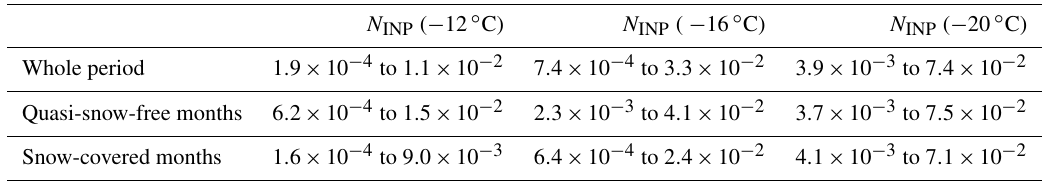
Table 1. Percentiles of N INP (10th to 90th) at − 12, − 16 and − 20 ◦ C for the whole period, quasi-snow-free months and snow-covered months, respectively.